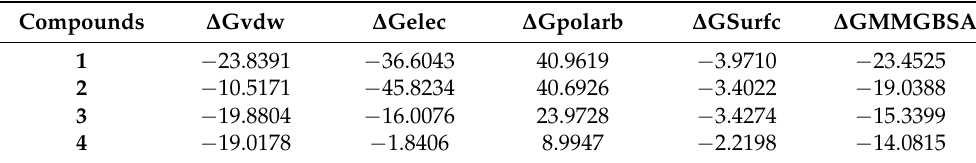
Table 2. Calculated binding free energies (kcal mol − 1 a ). Compounds ∆ Gvdw